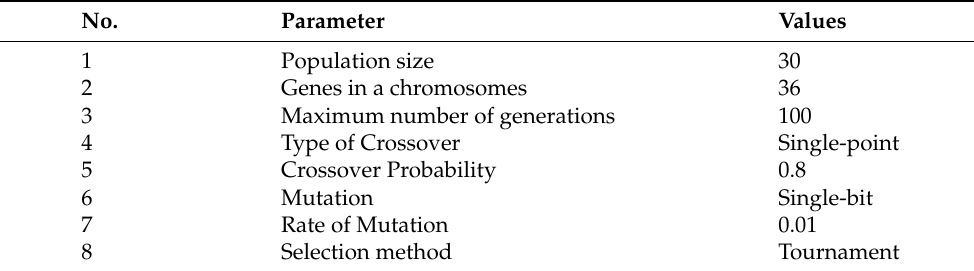
Table 1. Genetic algorithm optimization